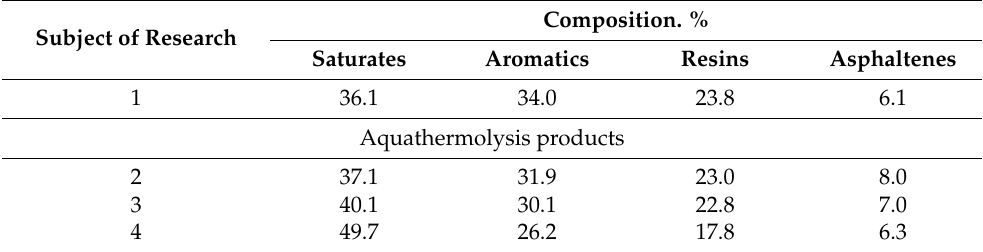
Table 4. SARA analysis of the oil extract before and after